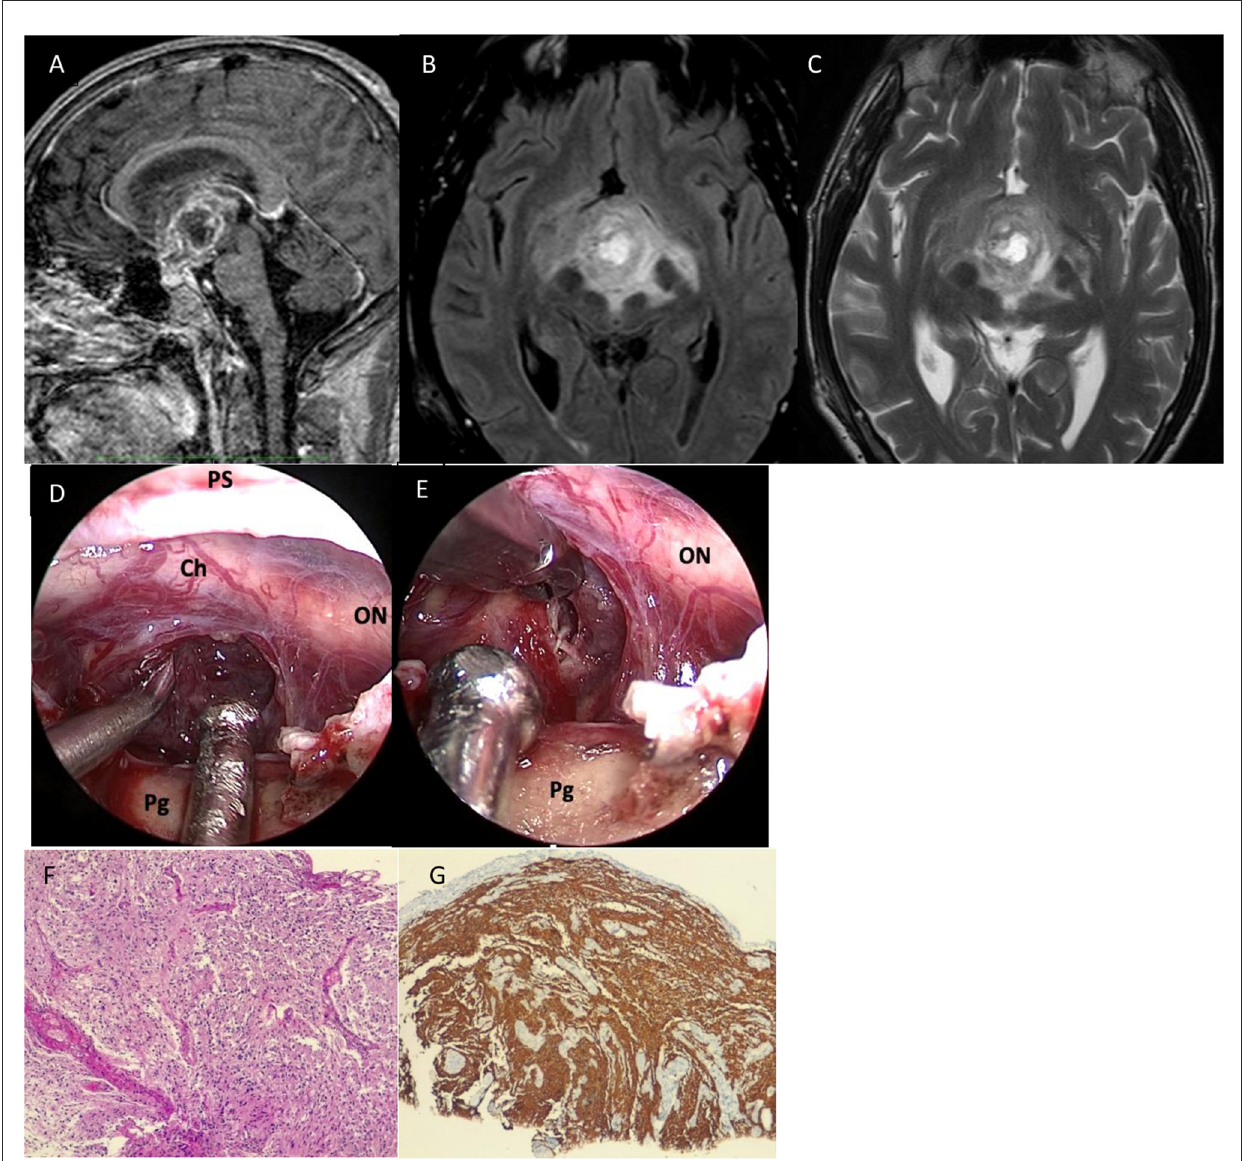
FIGURE1 Preoperative sagittal (A) , axial (B) T2, and axial (C) T2-fluid-attenuated inversion recovery (FLAIR) sequences showed a huge mass located in the median and paramedian portion of the hypothalamus-chiasmatic region (Dmax 50 cm), with irregular margins infiltrating the uncus-amygdaloid complex in the hypothalamus region and the floor of the third ventricle; the lesion presented central colliquative necrotic component and its signal was relatively homogenous with slightly hypointense in T1 and hyperintense on T2-weighted images, with significant heterogenous post-Gad enhancement and peripherical vasogenic edema. (D) After dural opening, the lesion appeared diffusely infiltrating the infundibulum and third ventricle, and it presented as a grayish-yellow tissue and was highly vascularized. (E) Further resection of the tumor was not performed because the tumor adhered tenaciously to surrounding structures. (F) Histological examination revealed a highly cellular neoplasm having a fibrillary background, composed of pleomorphic, medium-sized cells. Necrosis and microvascular proliferation were also seen ( hematoxylin-eosin, original magnification 10x ). (G) On immunohistochemistry, tumor cells were GFAP positive ( immunoperoxidase staining, original magnification 10x ). IDH1 immunostaining was negative (not shown in the figure). ON, optic nerve; Ch, chiasm; T, tumor; Pg, pituitary gland.